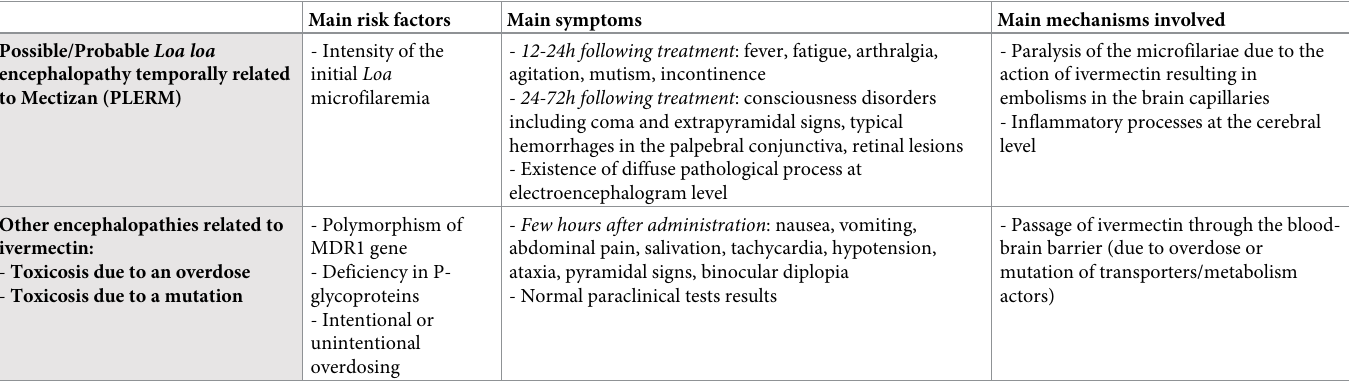
Table 7. Possible/Probable Loa loa encephalopathy temporally related to Mectizan and other encephalopathies related to ivermectin: mains risk factors, symptoms and mechanisms involved. Main risk factors Main